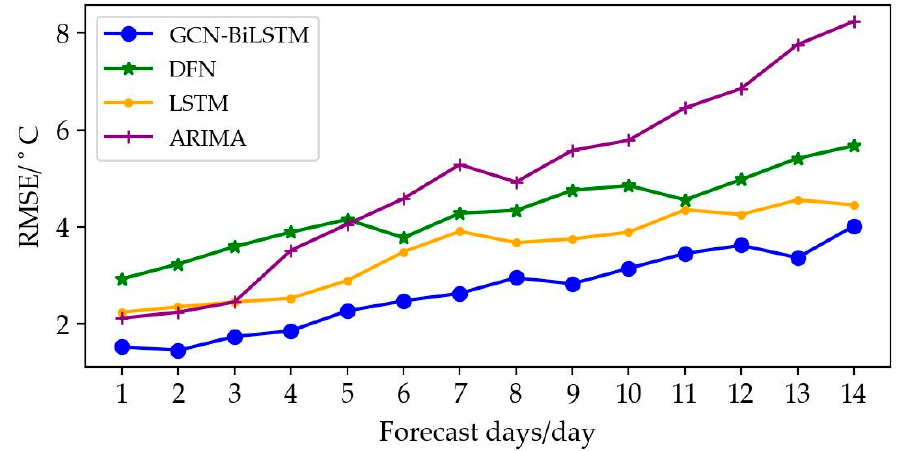
Figure 7. Comparison of RMSE of temperature prediction for the next 14 days.